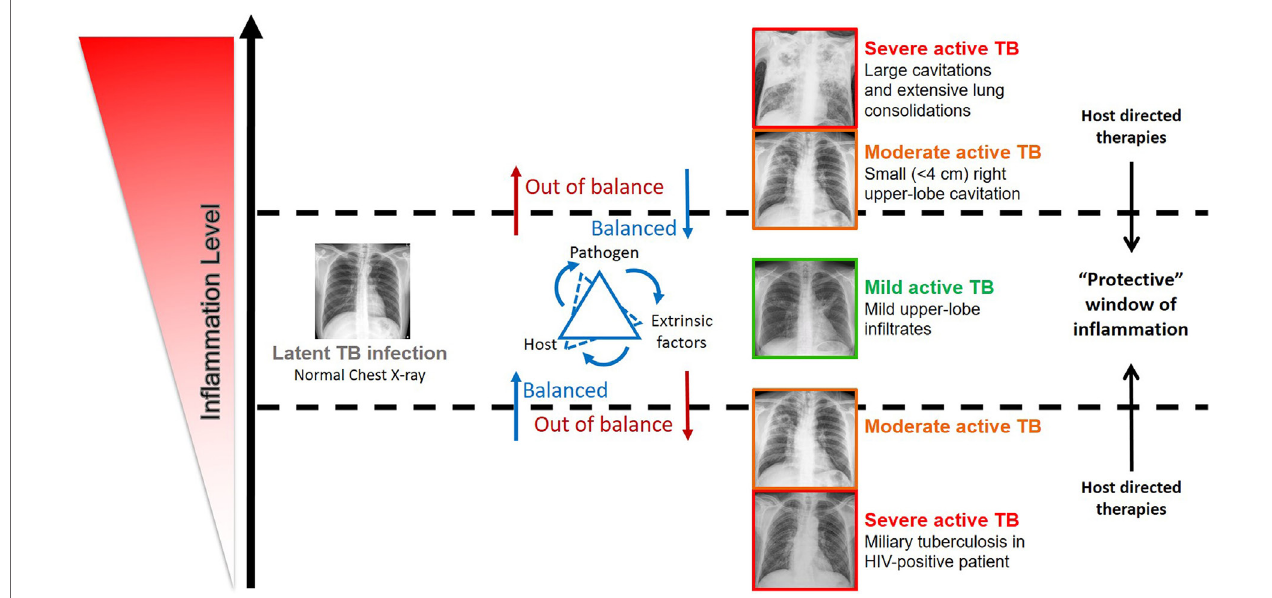
FigURe 1 | Impact of the inflammation level in the disease outcome in individuals infected by Mycobacterium tuberculosis complex bacteria. The spectrum of tuberculosis (TB) disease is strongly linked with the host immune status. The inflammation level results from the interaction of host, pathogen, and extrinsic factors. Very low and high inflammation levels often associated with severe active TB, while balanced immune responses associated with mild active TB, latent TB, and possibly TB clearance. Evidence supports that host-directed therapies (see Table 1 ) have the potential to successfully modulate inflammation and ameliorate disease outcome, by ensuring a protective immune response.